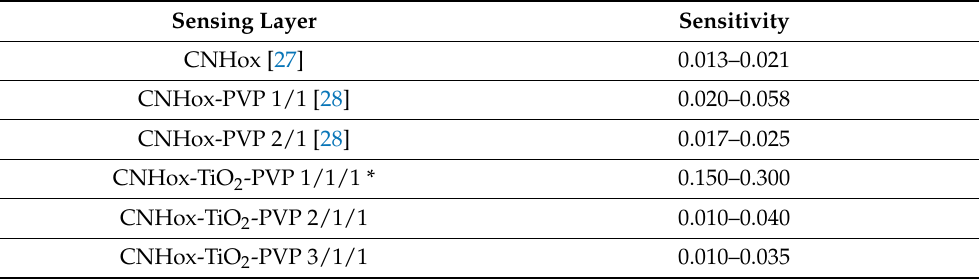
Table 1. Sensitivity of CNHox-TiO 2 -PVP compared with previously tested sensing layers. Sensing